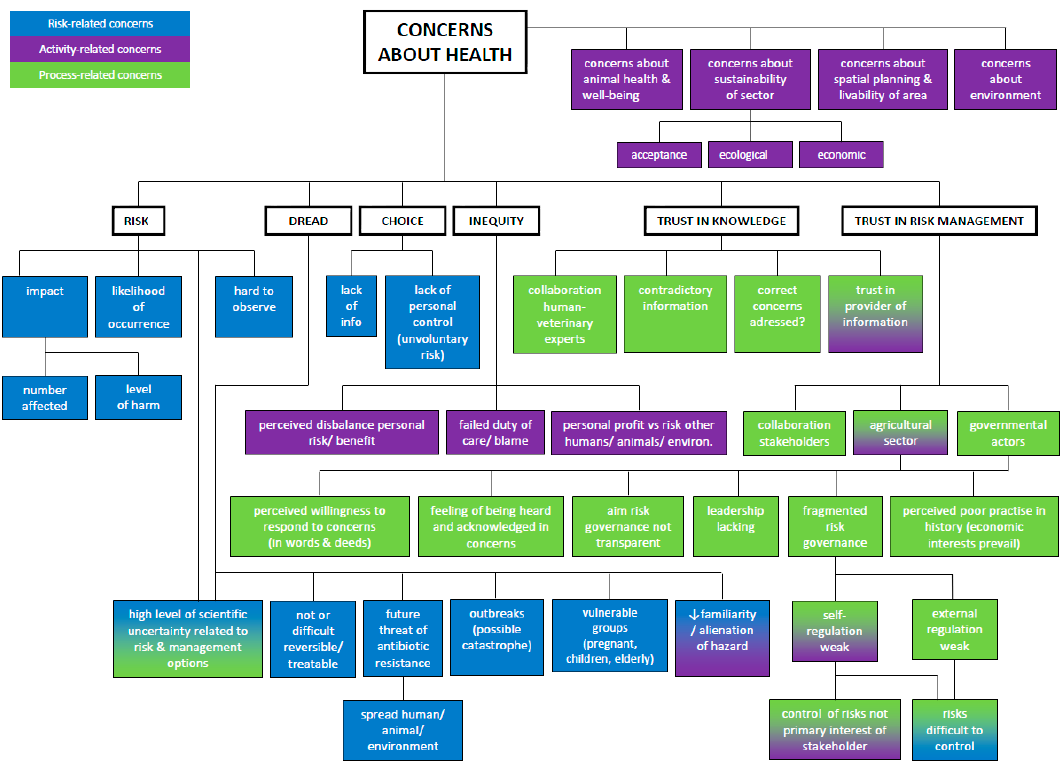
Figure 3. Structured map of stakeholder concerns.